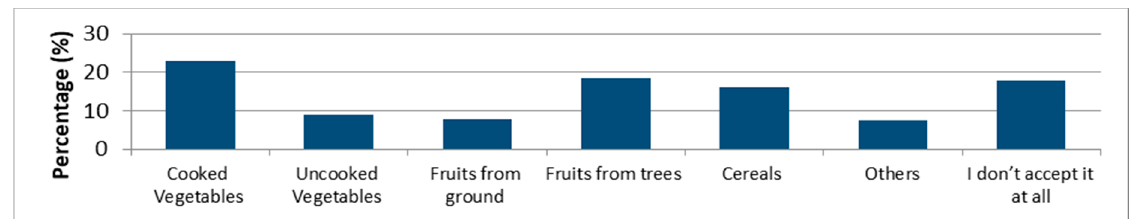
Figure 8. Preferences for green areas applications.